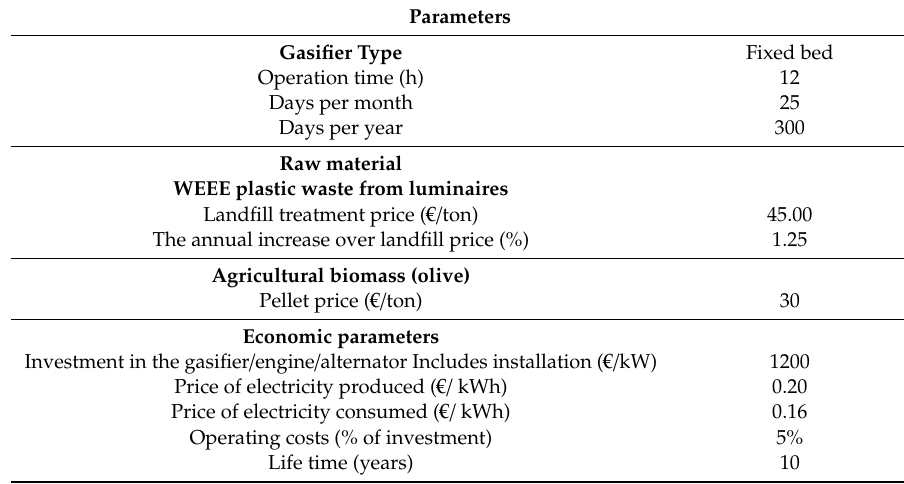
Table 6. Parameters for the economic analysis of the feasibility of installing a gasification plant. (Source: